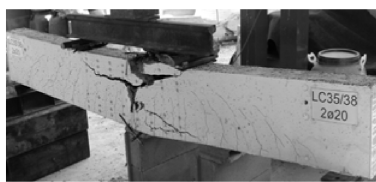
Fig. 3. Test beam after